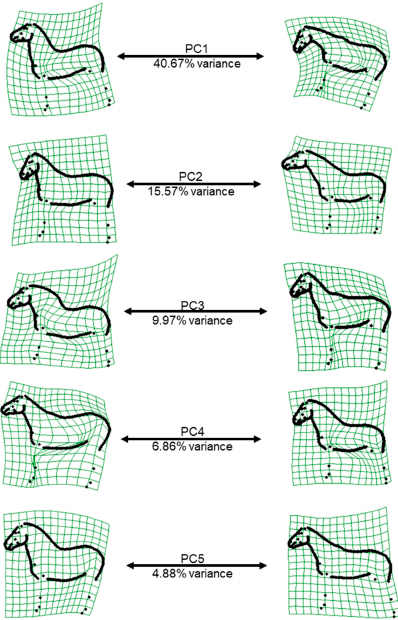
Figure 2. Representation of the extreme shapes describing the first five relative warp axes on warp grids from low ( left ) to high ( right ), with the percentage of explained variance under the arrow.